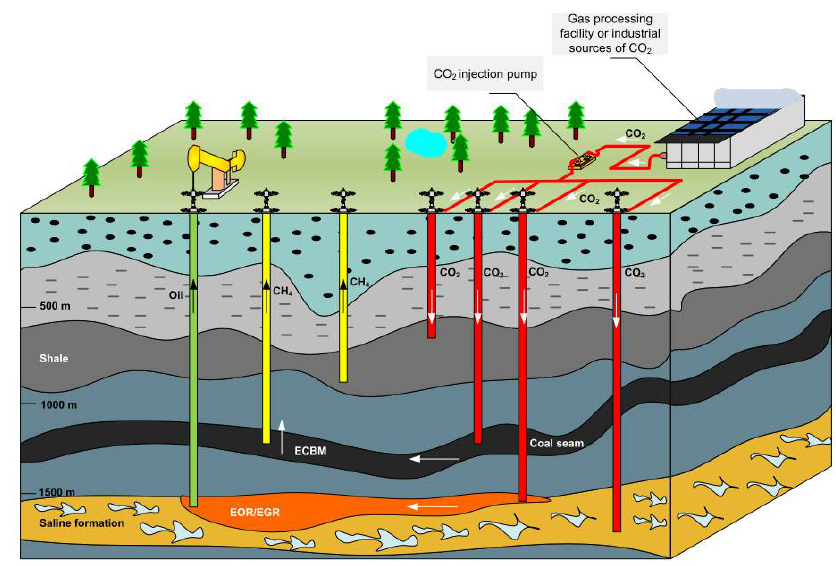
Figure 10. CO 2 enhances energy production [138].